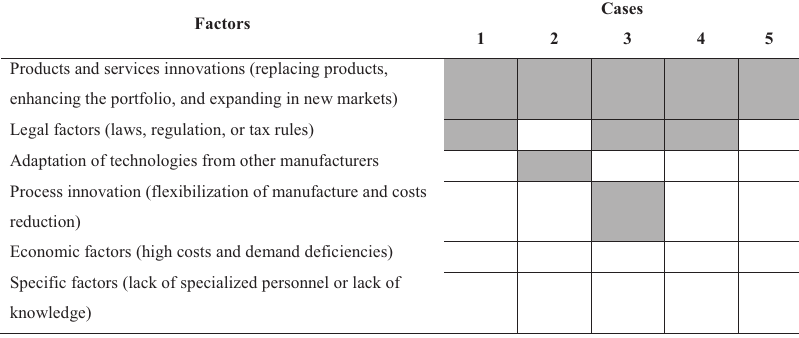
Figure 1. Motivating